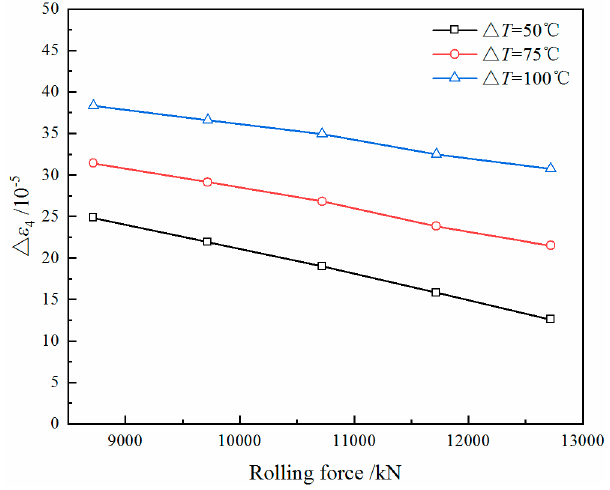
15 of 22 Figure 15. Bending force and Δ ε 4 of the strip with different values of Δ T . 3.3. Effect of Rolling Force